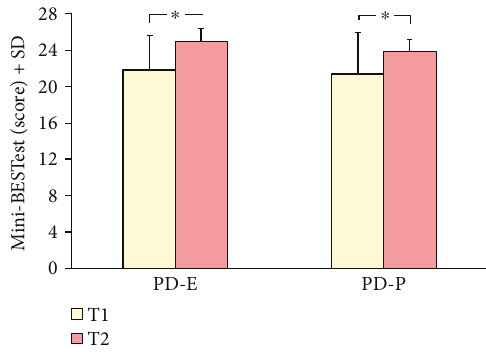
Figure 4: Training e ff ect on balance, measured by the total score of the Mini-BESTest. Yellow columns represent pretraining and pink columns posttraining evaluation. A signi fi cant di ff erence was found between T1 and T2 within each group (Wilcoxon test; ∗ p < 0 05